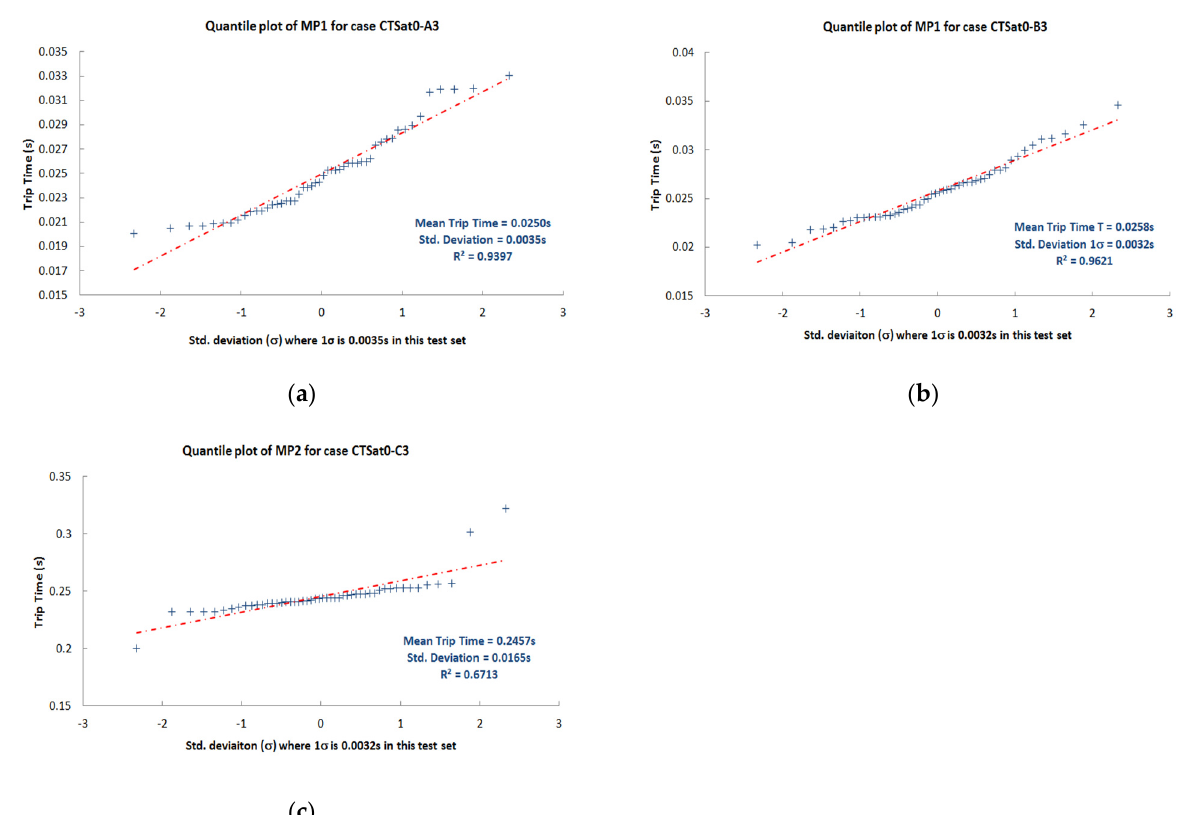
Figure 16. Quantile plot for cases: ( a ) CTSat0-A3 (ideal CT, no faulty components, L-L fault at 100% of the feeder); ( b ) CTSat0-B3 (ideal CT, 1 faulty fibre, L-L fault at 100% of the feeder); and ( c ) CTSat0-C3 (ideal CT, 1 faulty AMU, L-L fault at 100% of the feeder).